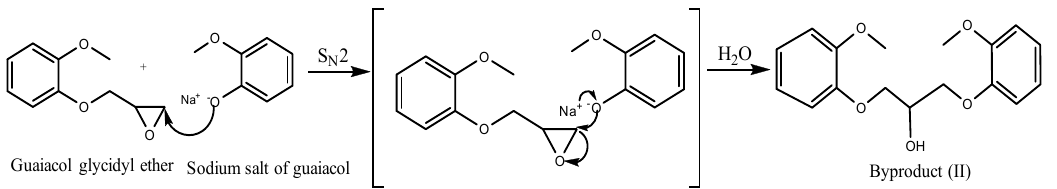
Scheme 2. By-product formation reaction.